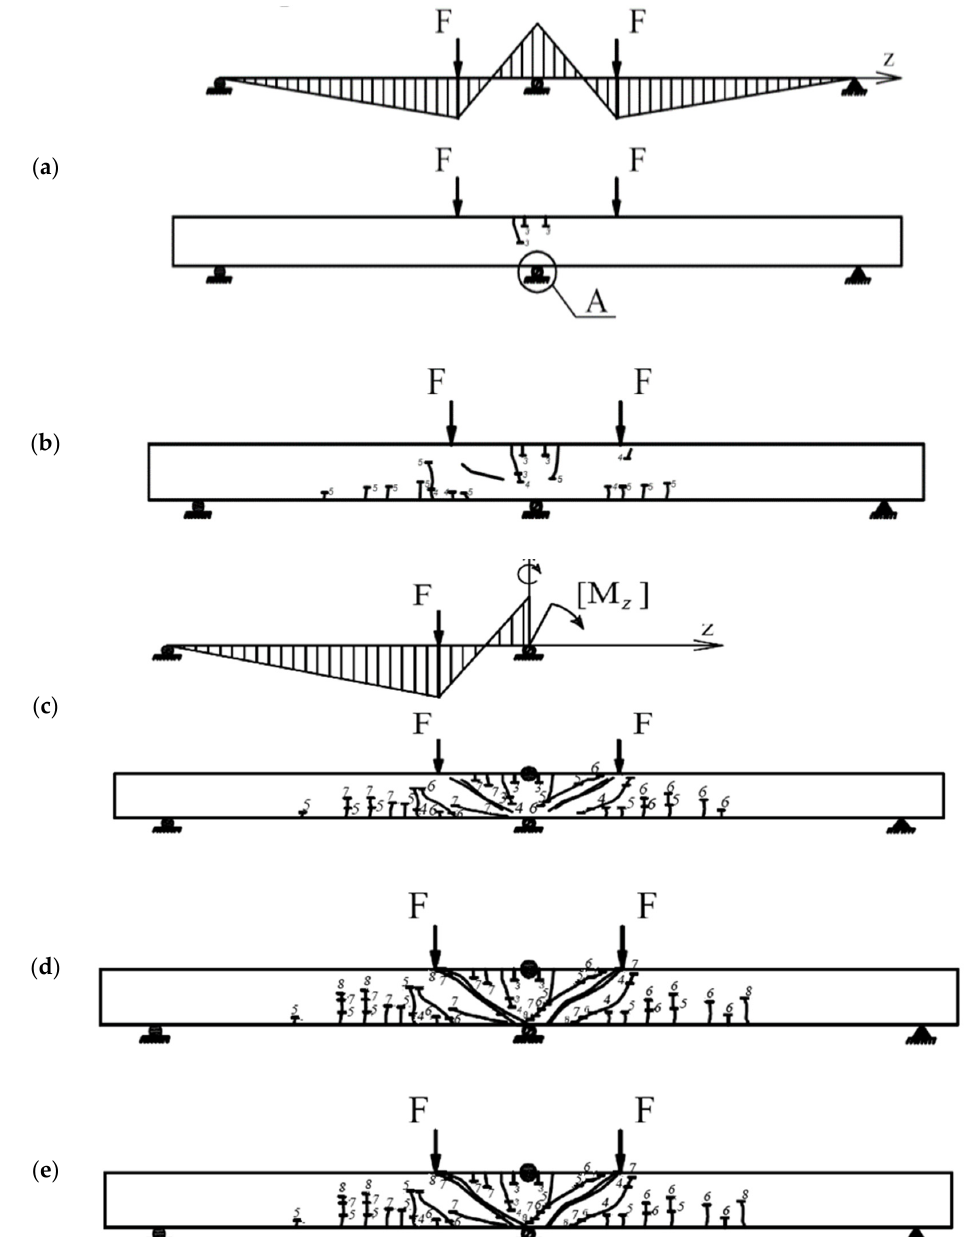
Figure 4. The mechanism of cracking, deformation, and fracture of a continuous two-span-reinforced concrete beam—grillage. Plot of M z before the appearance of the plastic hinge ( a , b ). Diagram M z after the appearance of a plastic hinge over the middle support ( c – e ). ( a ) The appearance of normal cracks above the middle support. ( b ) The development of normal cracks above the middle support, the appearance of normal cracks under concentrated forces (or inclined in the span of the shear). ( c ) The development of normal and inclined cracks, the appearance of a plastic hinge above the middle support, an increase in the flyby moment. ( d ) The development of normal and inclined cracks with a predominant opening of inclined cracks, up to failure along inclined cracks. ( e ) Fracture along inclined cracks with the formation of plastic joints under concentrated forces in beams with large and medium shear